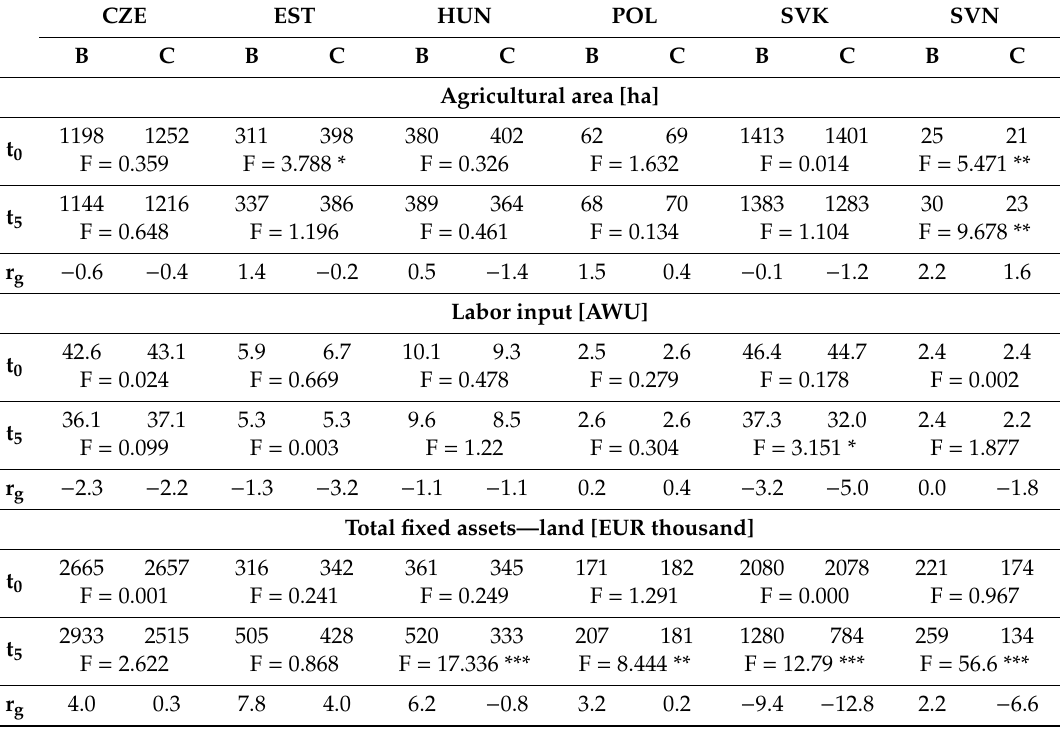
Table 5. Productive input resources in beneficiary farms in the base year (preceding the year where the beneficiaries accessed the pro-investment mechanisms under the second pillar of the CAP) and in the fifth year after they accessed the respective